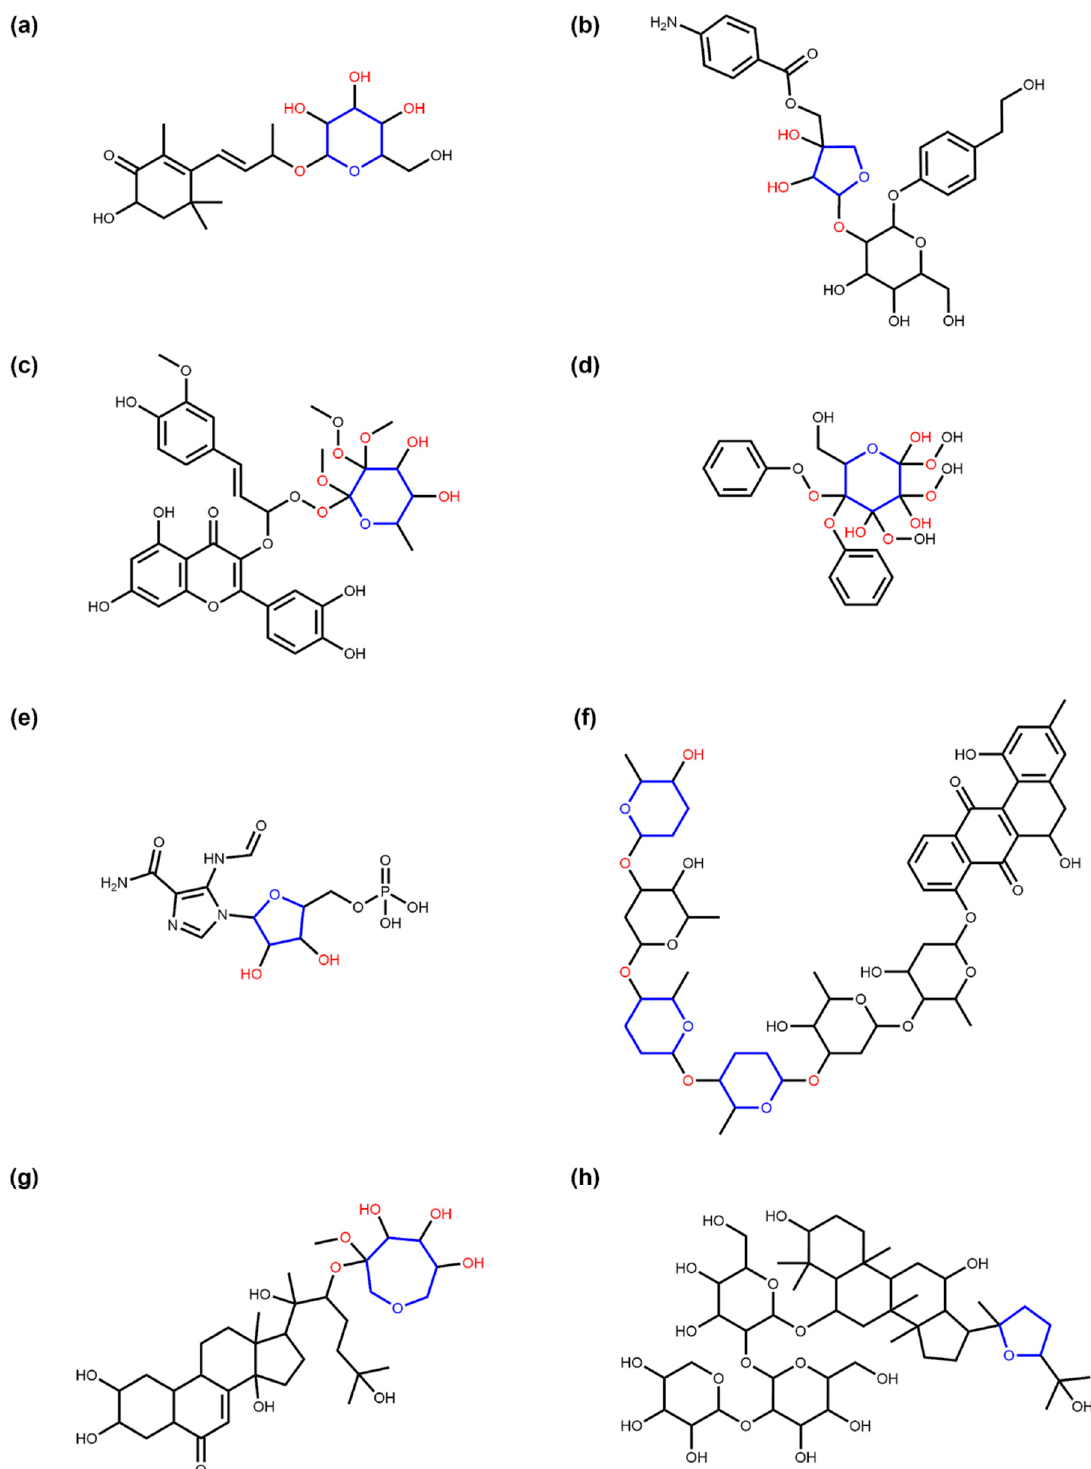
Figure 11. Examples of NP in COCONUT having circular sugar moieties with specific exocyclic oxygen atoms to atoms in ring ratio r exo values. The ratio is calculated by dividing the number of oxygen atoms attached to a furanose/pyranose/hep- tose ring n exo by the number of heavy atoms (C and O) in the ring n inc (see Equation (1)). In all subfigures, the respective sugar ring is marked in blue and all directly connected exocyclic oxygen atoms are marked in red. ( a ) Staphylionoside A (COCONUT ID CNP0250344), an NP with a pyranose sugar moiety that has an exocyclic oxygen ratio of 0.6 due to four connected oxygen atoms. ( b ) Cucurbitoside I (CNP0225316) contains a non-terminal furanose moiety with an exocyclic oxygen ratio of 0.6 due to the three connected oxygen atoms. ( c ) COCONUT NP CNP0030043 has a terminal pyranose moiety with an exocyclic oxygen ratio of 1.0 because the number of exocyclic oxygen atoms directly attached to the sugar